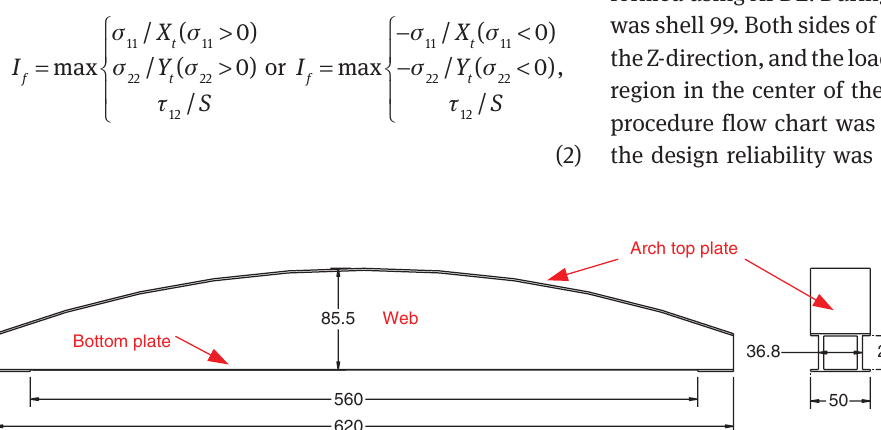
Figure 3: Dimensions of the studied composites box